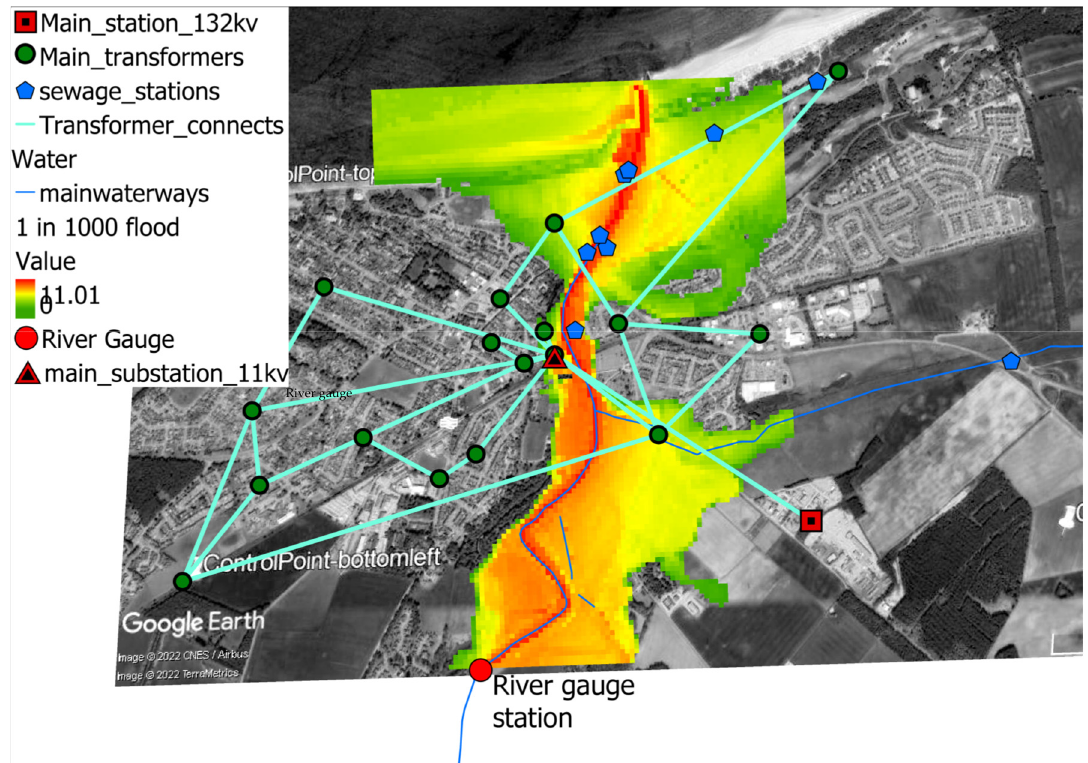
Figure 1. The network system and geographic locations of CIs in a small coastal town in the UK (the name and coordinates are not shown to ensure confidentiality). The cyan lines show the links in the simplified network model; the shaded areas are inundated areas for a 1 in 1000 year flooding event. The red dot indicates the location of the river gauge. See all the legend in the figure.